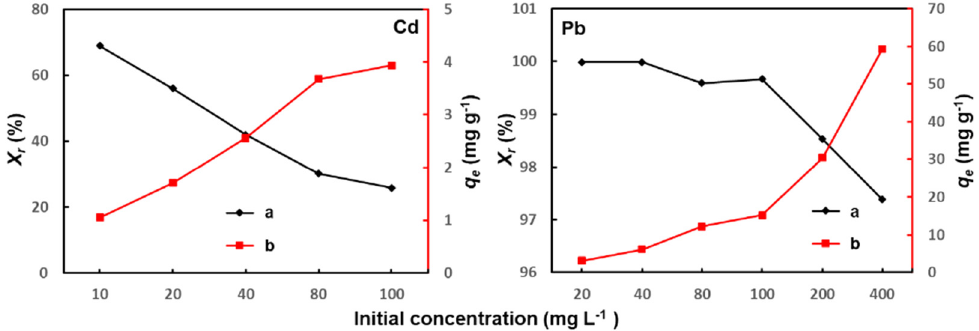
Figure 7: E ff ect of initial metal ion concentration on ( a ) the adsorption e ffi ciency and ( b ) the equilibrium adsorption of Cd 2 + or Pb 2 + on pollen@FePO 4 microspheres. Sample: 50 mL, pH 5.92; adsorbent dose 0.3278 g; contact time 60